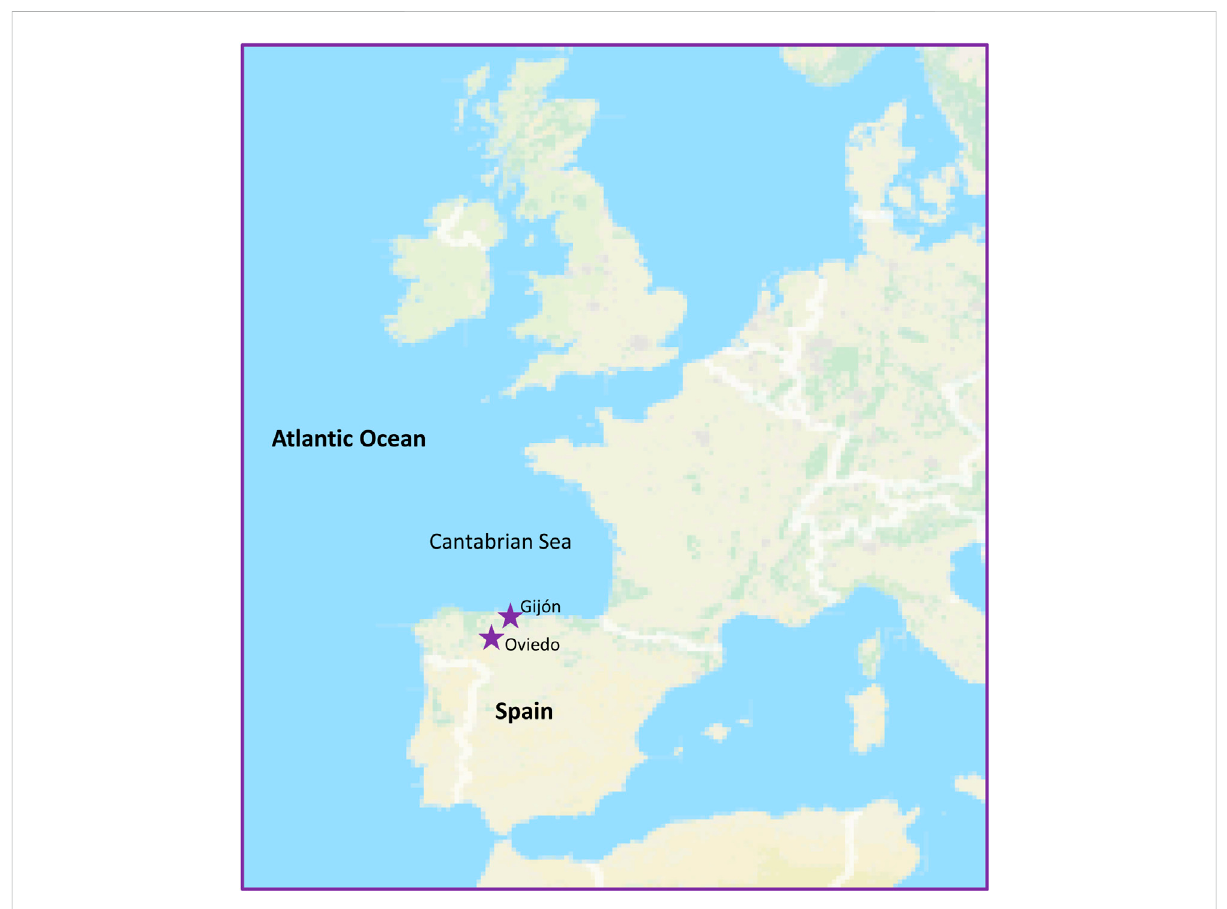
FIGURE 1 Sampling locations. Overview of the Western Atlantic Ocean and the sampling locations in Northern Spain indicated by